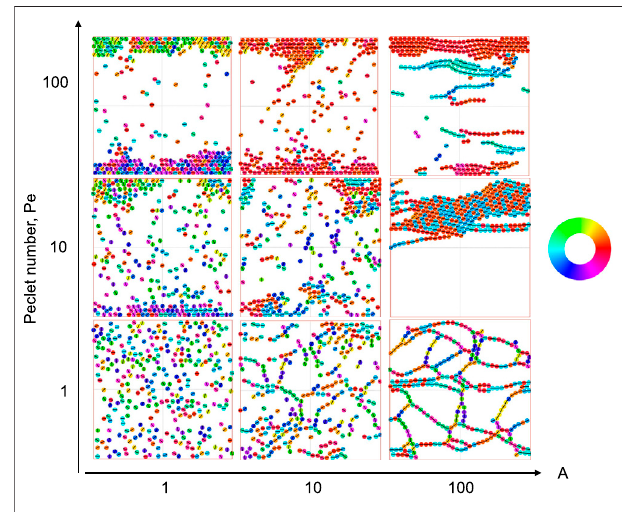
FIGURE 3 | Simulation snapshots of active particles with short range steric repulsions and long-range elastic dipole-dipole interactions as a function of effective elastic interaction A ≡ P 2 / E σ 3 k B T eff and Péclet number Pe ≡ σ v 0 / D T .Particlesarecon fi nedinthe y -direction,whiletheyexperience periodic boundary conditions inthe x -direction. They arecoloredaccordingto their self-propulsion direction ^ n , and coded based on the color wheel. Motile particles at low effective elastic interaction collect into clusters at the boundaries. Strong elastic interactions promote network formation at low activity. Strong elastic interactions paired with high activity gives rise to active polymers and polar bands. The full movies corresponding to ABPs, networks, travelingcluster,andactivepolymerscanbeseenin Supplementarymovies S1 – S4 ,